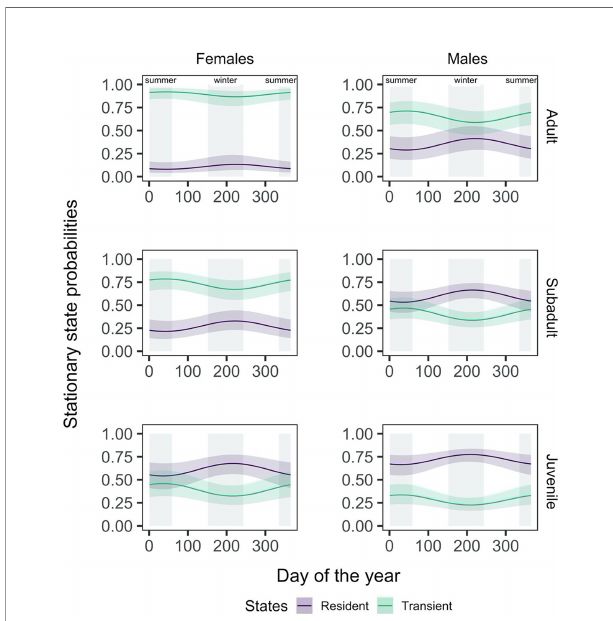
FIGURE 5 | The effect of day of the year on the probability of fi nding a shark in a given state, shown here by sex (females: left column, males: right column) and life stage (adult: top row, subadult: middle row, juvenile: bottom row). The shading around the state line represents the 95% con fi dence interval around the mean